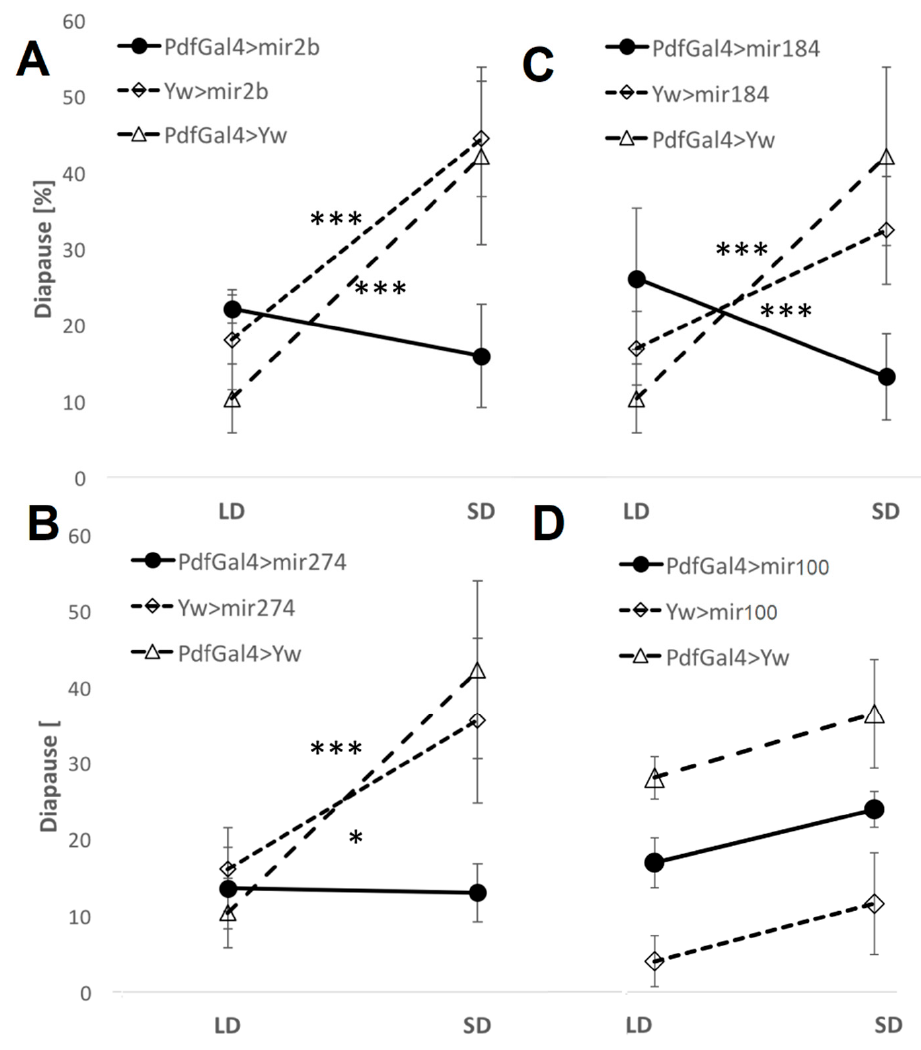
Figure 4. miRNA overexpression causes a loss of photoperiodic response. Average diapause [%] in flies overexpressing ( A ) dme-mir-2b , ( B ) dme-mir-184 , ( C ) dme-mir-274 , and dme-mir-100 ( D ), in PDF-expressing cells. Error bars represent SEM. Significant Phot:Gen interactions [ p < 0.001 (***), p < 0.05 (*)] indicate a different photoperiodic behavior between overexpressing lines and controls. dme-mir-100 is not a photoperiodic miRNA, and the experiment serves as a negative control.